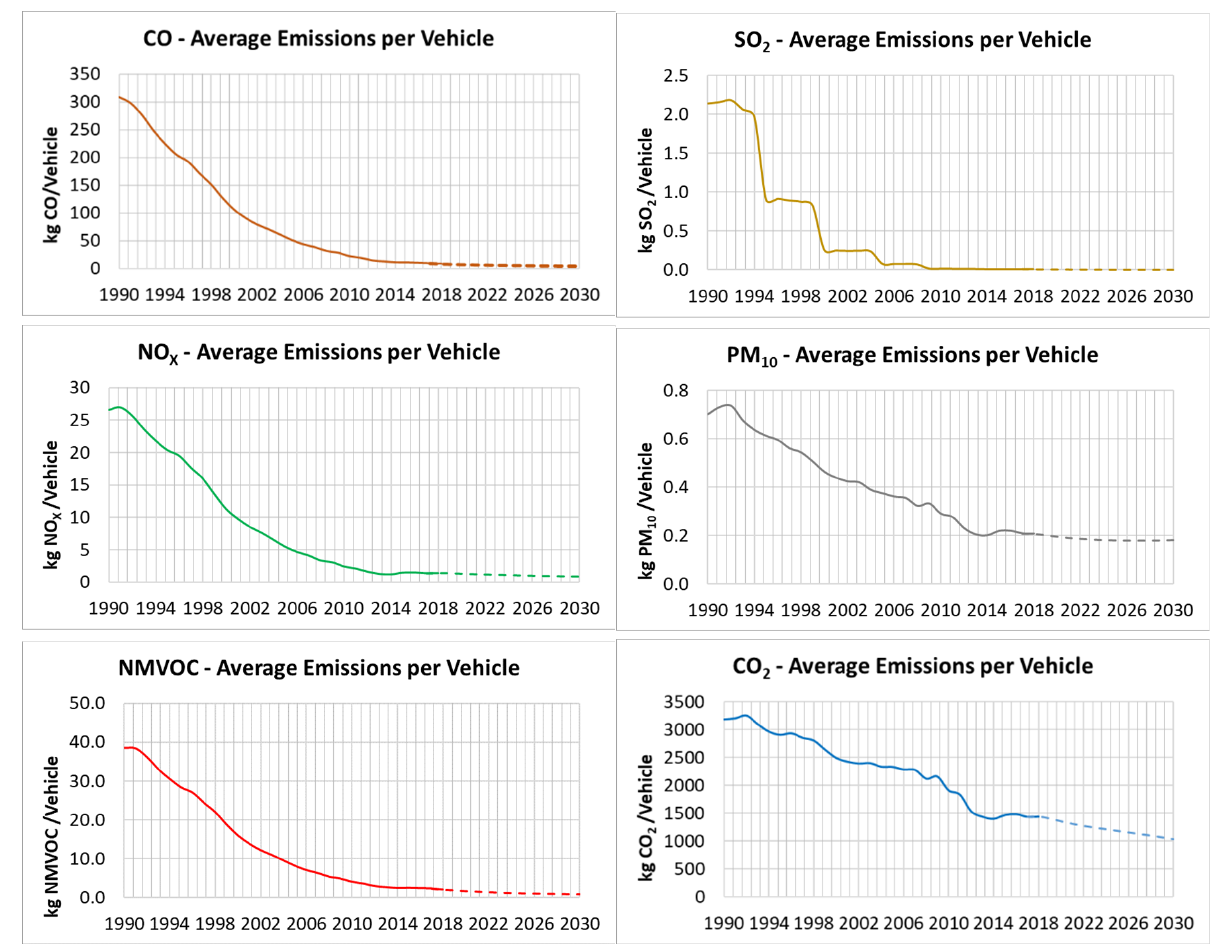
Figure 18. Average values of emitted air pollutants and CO 2 by vehicle, for the tested period between 1990 and 2030, in Greece.